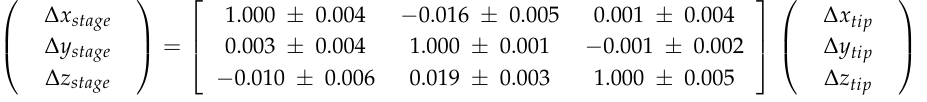
Figure 6. Sample scanning AFM setup used for testing the new 3D-AFM head. The electronics, detectors, data acquisition, and regulation (control unit) are also built by PTB staff as well as being based on earlier developments [8] and are not explained in detail in this paper. The focus is on the self-build 3D-AFM head, marked red in Figure 6 and detailed in Figure 7. It is designed to detect the three DOFs of the 3D-Nanoprobe’s tip